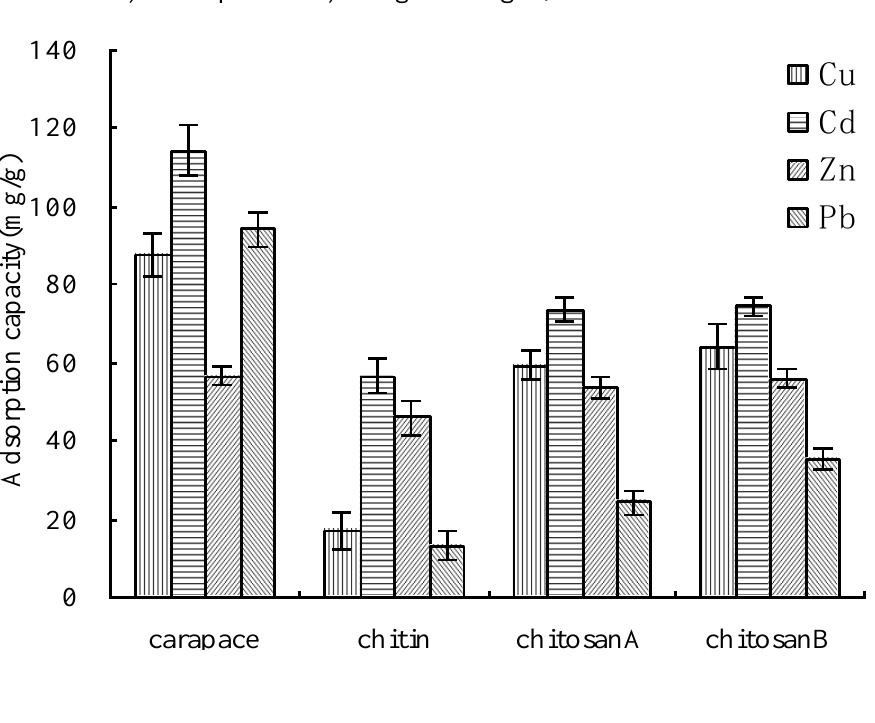
Figure 9. Adsorption capacities of the four metal ions on different adsorbents (initial metal concentration = 100 ppm; agitation speed = 180 rpm; equilibrium time = 2 h; temperature = 25 °C; initial pH = 5.5; dosage = 1.0